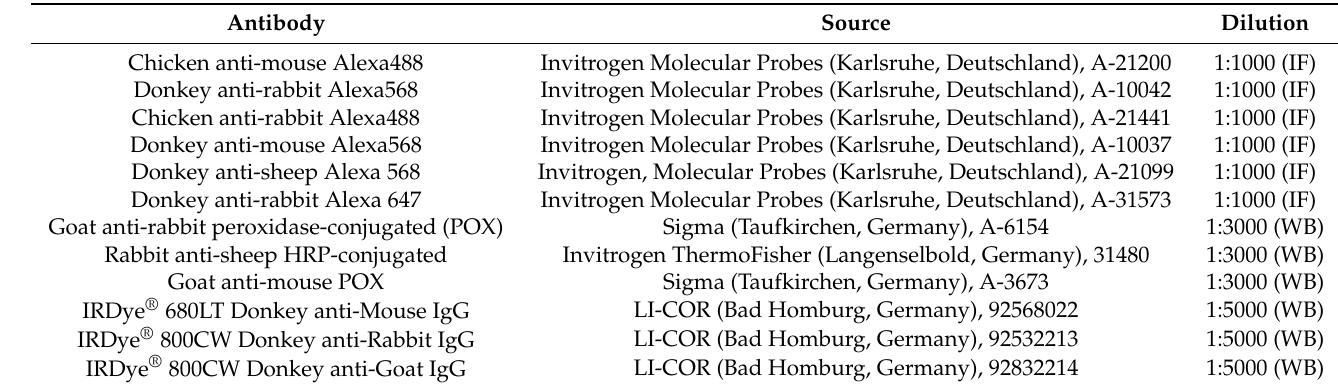
Table 2. Secondary